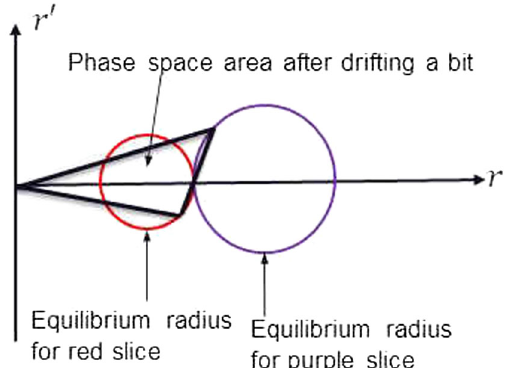
FIG. 8. Starting at the same radius (where the red and purple circles touch), the edge of the end slice will oscillate about a smaller radius (red circle) than the edge of the middle slice (purple circle). The electron orbits are clockwise in radial phase space, and the boundary of the bunch ’ s projected phase space is represented by the black triangle after the bunch drifts a while. As the colored circles represent the radii of the edges of the center and edge slices, other particles from those slices lie on the two mostly horizontal black lines.